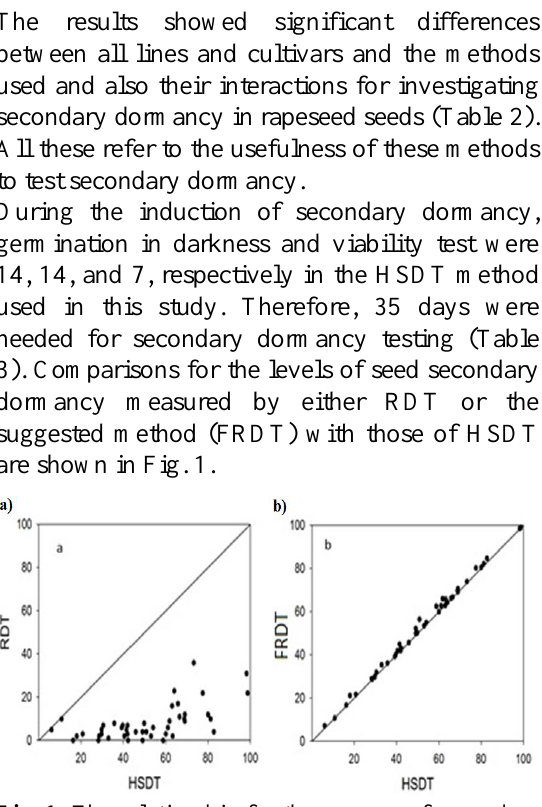
Fig. 1. The relationship for the average of secondary dormancy percentages is obtained from the comparison of the HSDT method to those obtained from RDT (a) and FRDT (b)